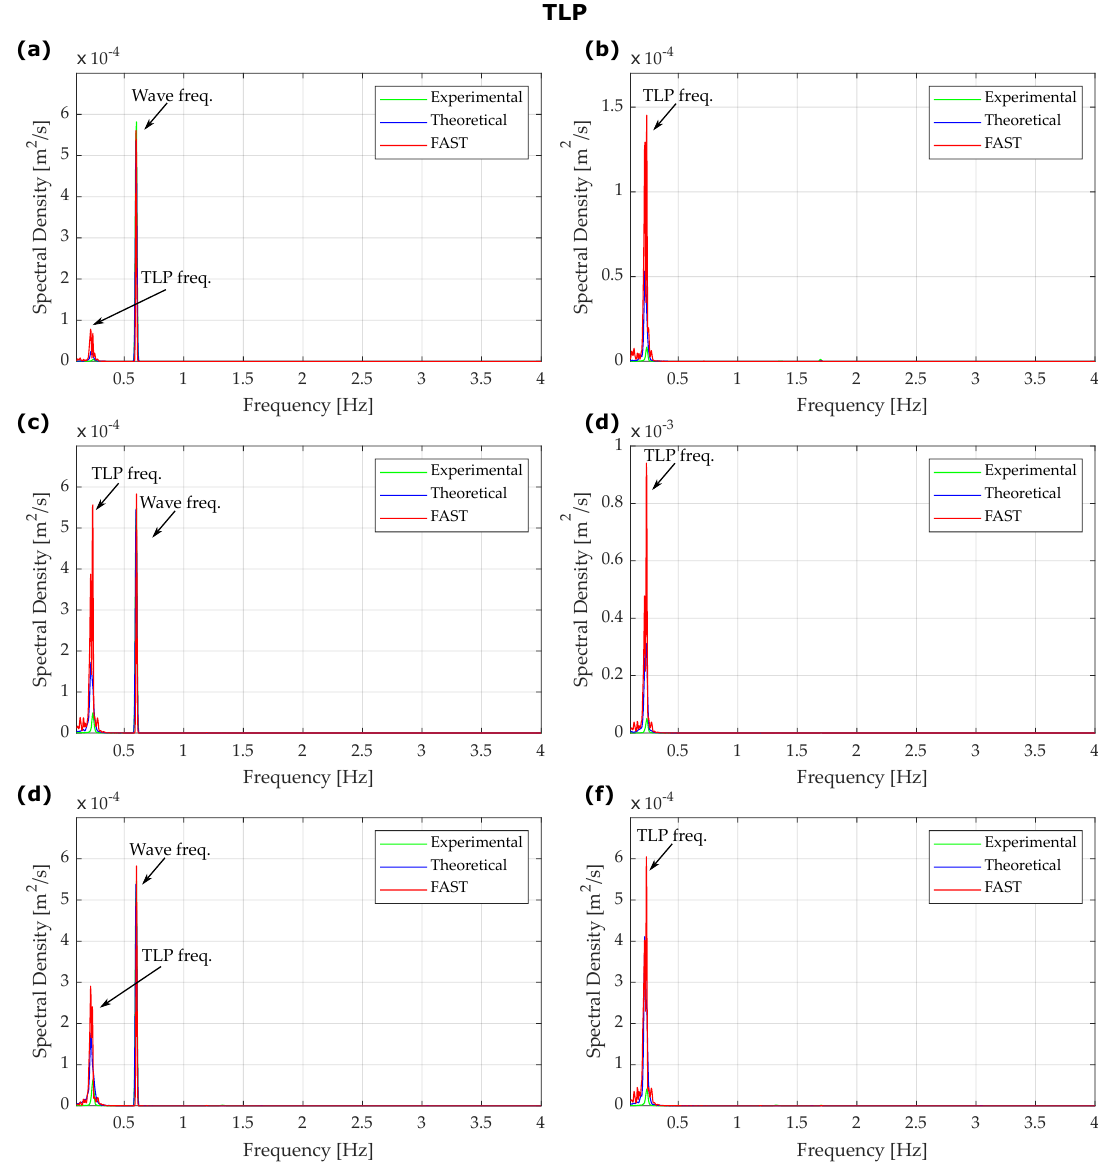
Figure 12. The PSD of the displacement time series of the TLP in surge from experiments and simulation by FAST and the theoretical model under different aerodynamic and hydrodynamic loading conditions. The waves are monochromatic with an amplitude which is set to 0.01 m. ( a ) Wave frequency set to 0.6 Hz and wind speed set to 4 m/s. ( b ) Wave frequency set to 1.7 Hz and wind speed set to 4 m/s. ( c ) Wave frequency set to 0.6 Hz and wind speed set to 7 m/s. ( d ) Wave frequency set to 1.7 Hz